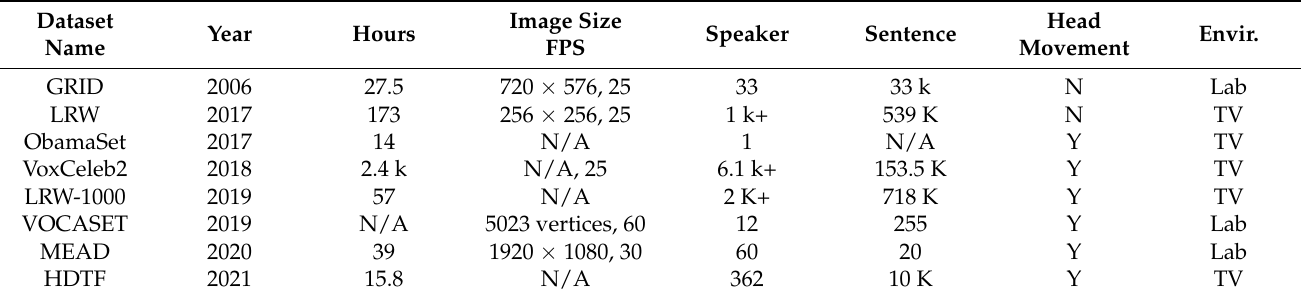
Table 2. Summary of talking-head video